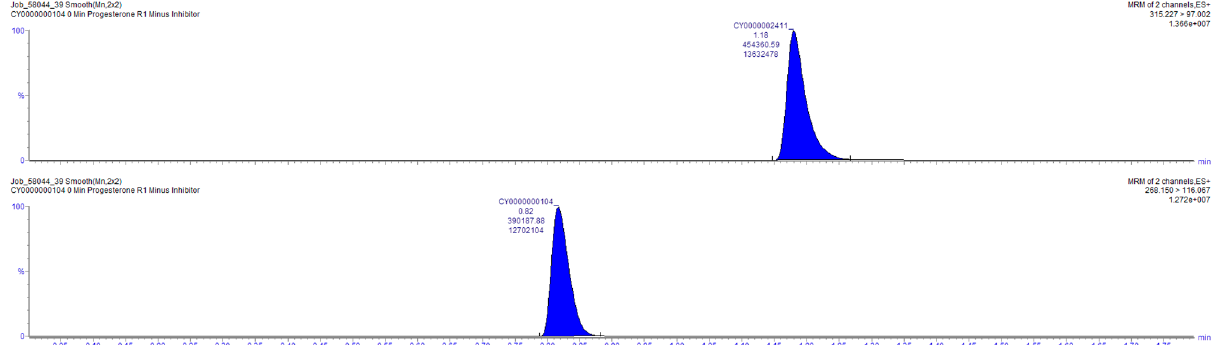
Figure A1 . Mass spectra showing progesterone (labelled CY0000002411) and metoprolol (labelled CY0000000104) at 0 min timepoint minus inhibitor. Control Substance Clearance in Human Liver and Intestinal Homogenates and Cy- tosol.